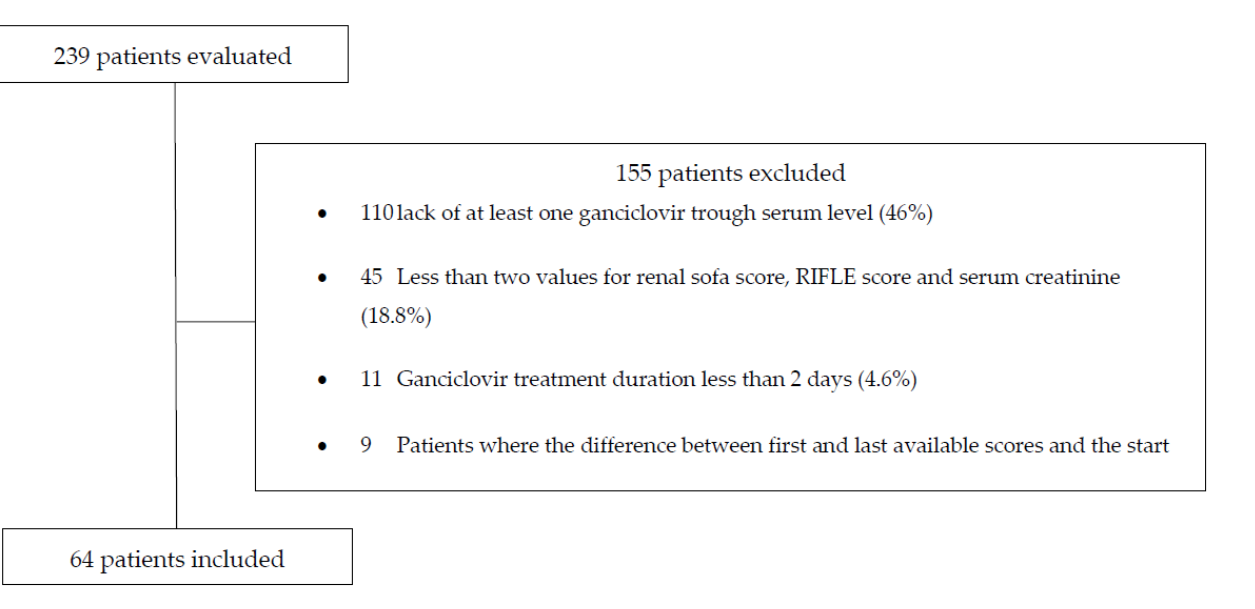
Figure 1. Patient enrolment.